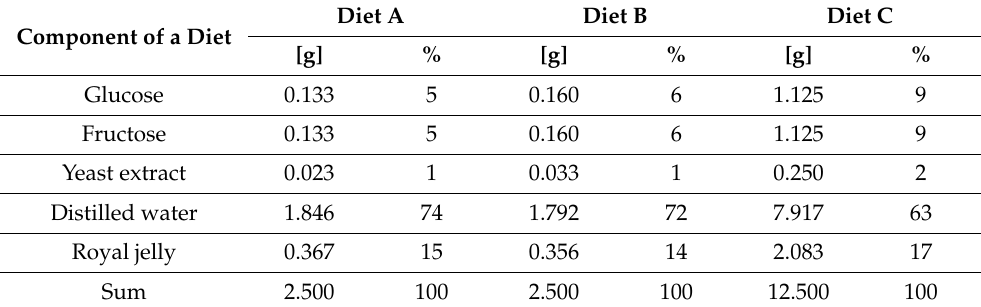
Table 1. Amount of each dietary component per 100 larvae for control group (with distilled water). Diet A Component of a Diet